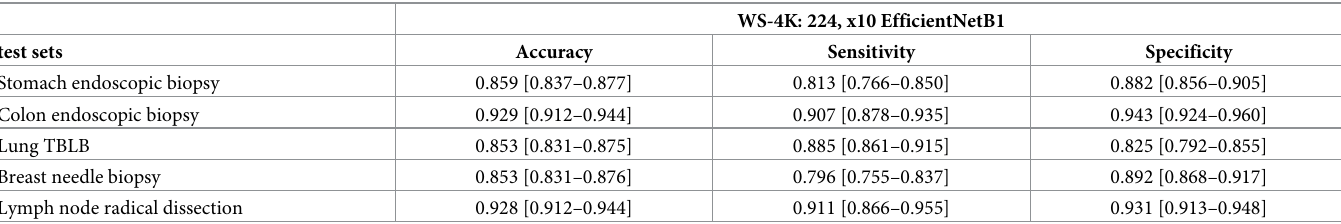
Table 7. Scores of accuracy, sensitivity, and specificity on test sets using the best model (WS-4K: 224, x10 EfficientNetB1).